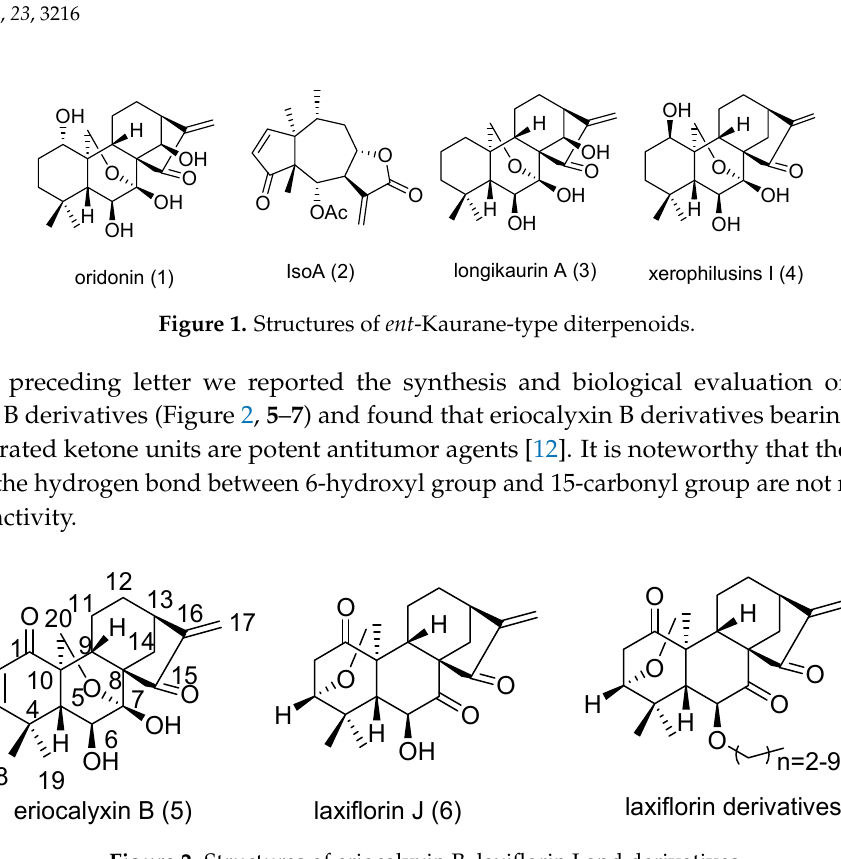
Figure 2. Structures of eriocalyxin B, laxiflorin J and derivatives.